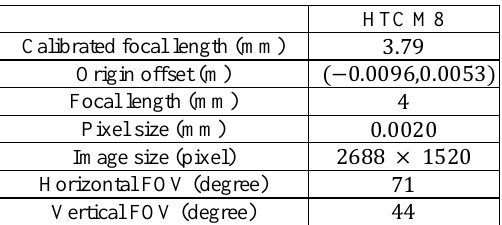
Table 1. The specification of